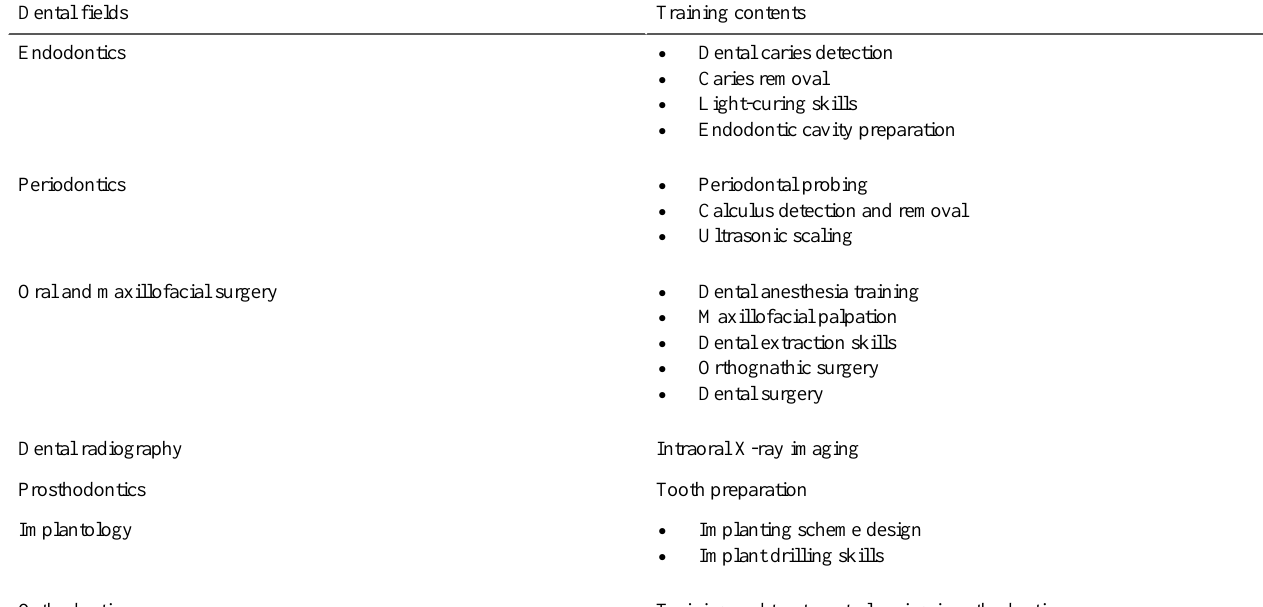
Table 2. Applications of dental simulators in dental